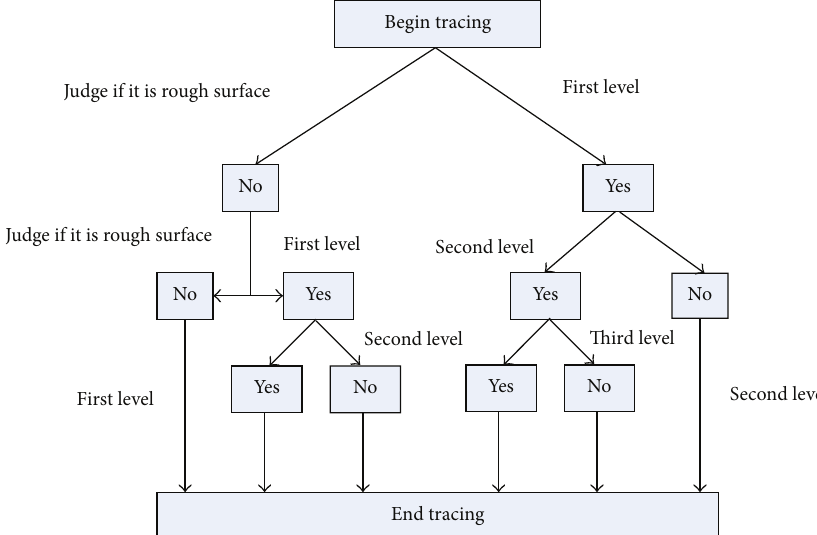
Figure 2: Schematic diagram of MBTT method.